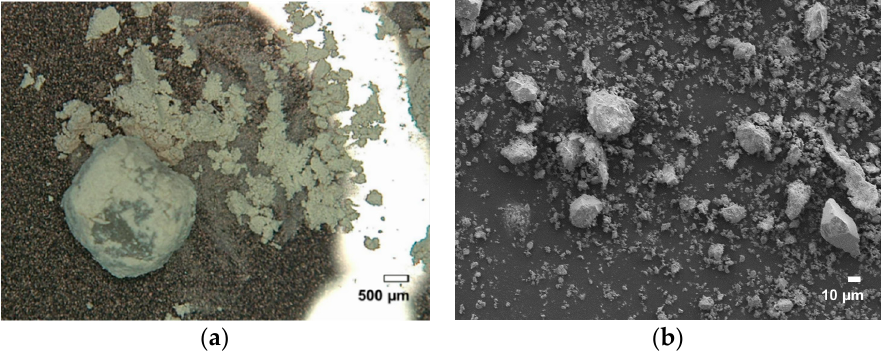
Figure 3. ( a ) Microscopic image of PSU taken after 10 min ball milling with ( b ) enlargement by SEM of the fractionated powder.